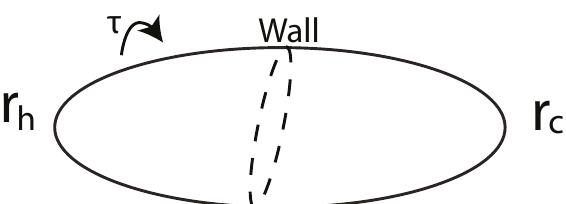
Figure 3 . A bubble (domain wall) with radius R is generated in Euclidean space. The entire space is between the black hole horizon, r h , and the cosmological horizon, r c . The coordinate τ is periodic, and its period is the inverse